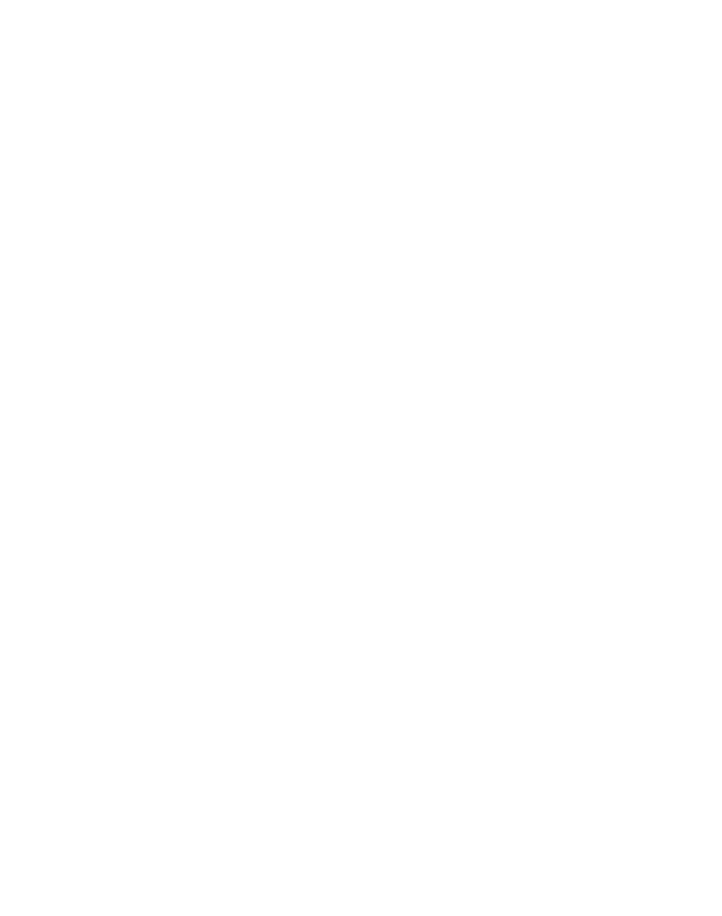
TGF-β regulates the actin cytoskeleton and Arp2/3 complex activity. (A) Phalloidin staining of actin filaments in cells treated with 2 ng/ml TGF-β1 for 24 h, either alone or in the presence of the p38MAPK inhibitor SB202190 (10 μM), the MEK inhibitor U0126 (5 μM) or the Raf1 inhibitor (5 μM). Arrows indicate the disruption of actin adhesion belts in LM3 cells treated with TGF-β. Note extensive actin stress fibers in TGF-β-treated cells in the presence of MEK or Raf inhibitor. (B) Tropomyosin (TPM) immunoblot in LM3 cells in response to 2 ng/ml TGF-β1. NMuMG cells were used as a control. (C) Phosphorylated MLC2 immunoblot in response to 2 ng/ml TGF-β1. (D) Arp2/3 complex activity in LM3 cells treated with or without 2 ng/ml TGF-β1, by an affinity pull-down assay. Precipitates (P) or supernatants (SN) were analyzed with Arp3 antibodies. (E) Arp2/3 complex activity in response to TGF-β, in the presence of the kinase inhibitors SB202190 (10 μM) or U0126 (5 μM).